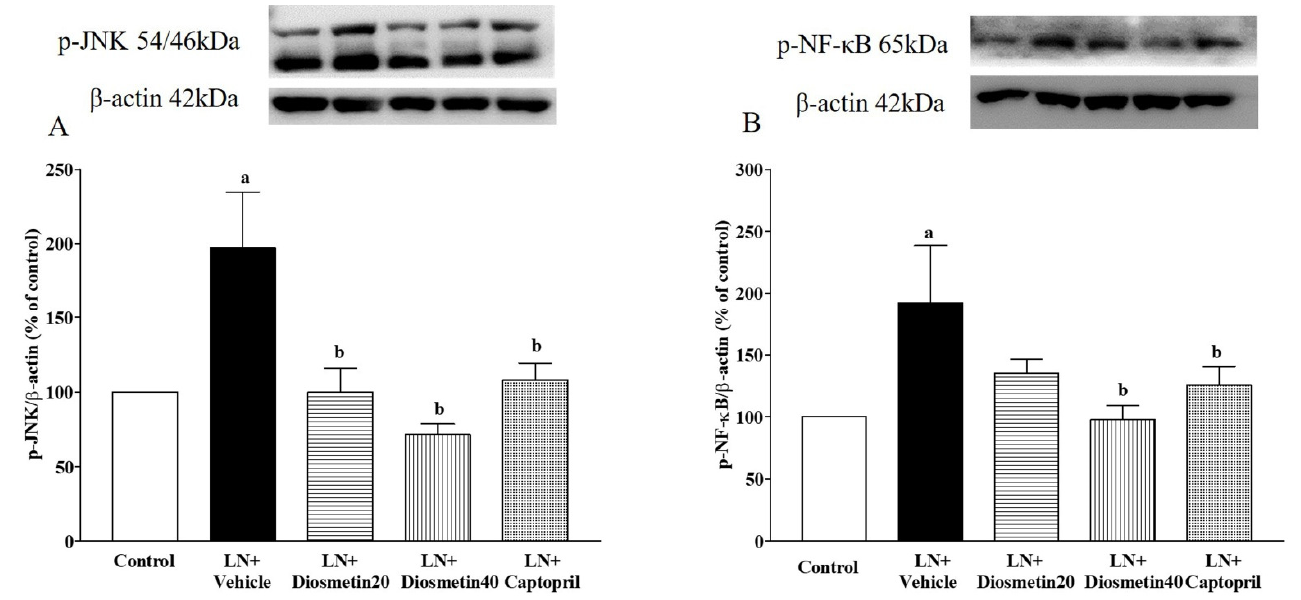
Figure 9. Effect of diosmetin and captopril on the p-JNK/p-NF- κ B protein expression in vascular tissue ( A , B ) in